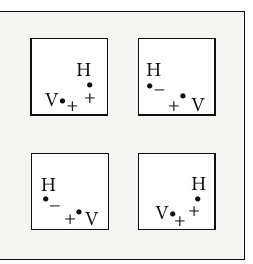
Figure 12: A simple 2 × 2 mirror array configuration of the CPAD.